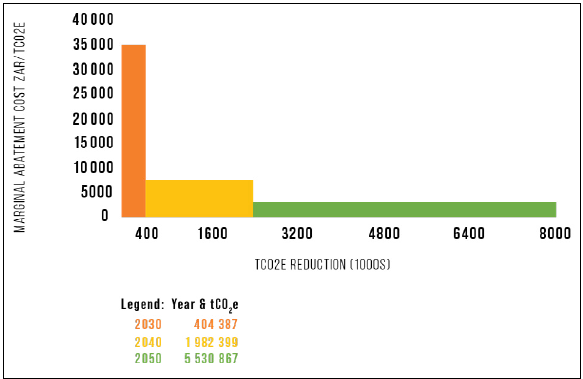
Figure 5: Marginal abatement cost curve for the transportation sector in 2030, 2040, and 2050.